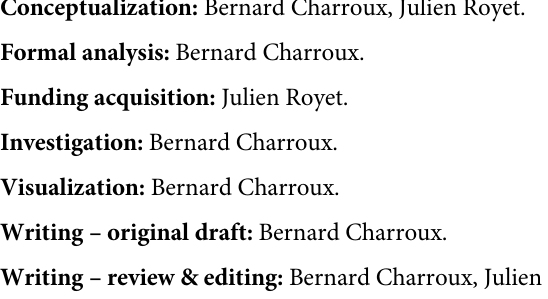
S7 Fig. Gut bacteria promote cell surface recruitment of tGPH in adipocytes and this is not affected by over expressing IMD or PGRP-LCa cell autonomously. Confocal images of fat body from adult flies fed 2 days with either sucrose, or a mixture of sucrose + E . faecalis or heat killed (H.k) E . coli , and showing the tGPH marker (green). Ingestion of heat killed E . coli promote recruitment of tGPH at the cell surface of adipocytes, compared to a sucrose diet. (B) Confocal images of fat body showing clones of adipocytes overexpressing IMD or PGRP-LCa (red) and the tGPH marker (green), from flies fed 1 day with E . cc or 2 days with E . coli . Fat body clones over expressing either IMD or PGRP-LCa do not affect tGPH recruitment at the cell surface of adipocytes. Flies of the following genotypes were used: w 1118 / w 1118 ; tGPH/tGPH (A) and w 1118 , CoinFLP Gal4 / w 1118 ; tGPH , UAS-CD4 :: Tomato/hs-FLP . G5 , Tub Gal80ts ; UAS-IMD or UAS-PGRP-LCa/+ . Scale bar is 20 μ m. (TIFF) S1 Numerical data. Numerical data underlying the results.